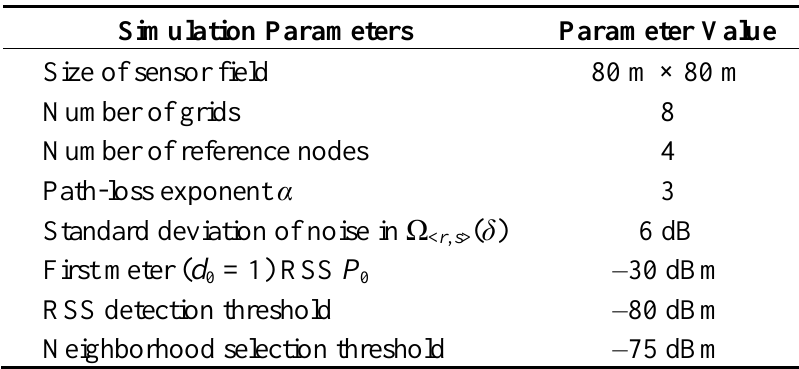
Table 1. Simulation